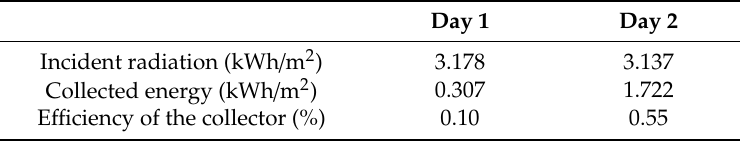
Figure 14. Experimental results for the irradiance and solar production during Days 1 and 2. Table 4. Comparison of the efficiency and energy harnessed by the ASTF.